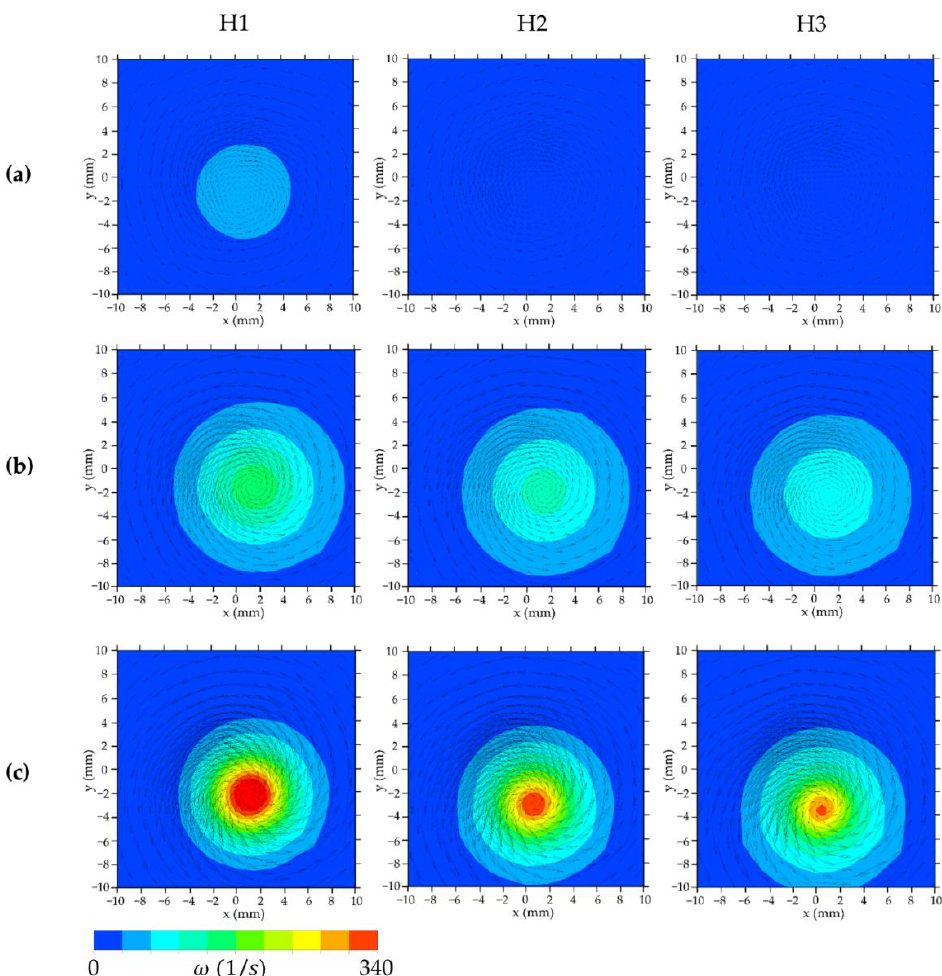
Figure 6. Velocity vectors represent the tangential projection of the average liquid velocity on horizontal planes for cases: ( a ) 𝐶 𝑠𝑐𝑎𝑙𝑒 = 0, ( b ) 𝐶 𝑠𝑐𝑎𝑙𝑒 = 0.5, ( c ) 𝐶 𝑠𝑐𝑎𝑙𝑒 = 1. The background color represents the average liquid vorticity magnitude. The results are obtained from the simulations using 𝐶 𝑒𝑛𝑡 = 2E-4. Horizontal planes H1, H2, and H3 are located 10, 20, and 30 mm above the bottom surface of the cylindrical vessel, respectively.